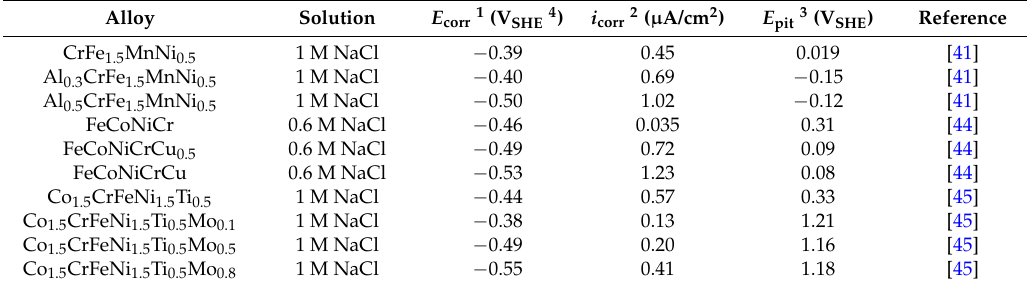
Table 1. Electrochemical parameters of high-entropy alloys (HEAs) in the chloride-containing solution at room